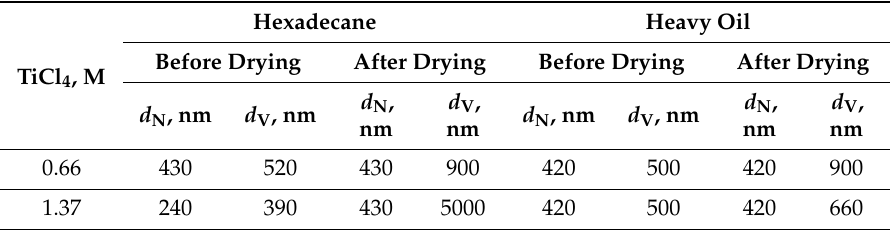
Table 1. Particle aggregate sizes represented as mean diameter by number, d N , and by volume, d V , as measured by DLS at di ff erent concentrations of the TiCl 4 precursor, after particle synthesis in emulsions formed in hexadecane or heavy oil. The Span 80 concentration in the oily phase was 1 wt % in all these experiments. The preparation of the initial emulsions was performed with Ultra Turrax at 20,500 rpm for 5 min, whereas the mixing of these emulsions was made for 10 min at the same rotation